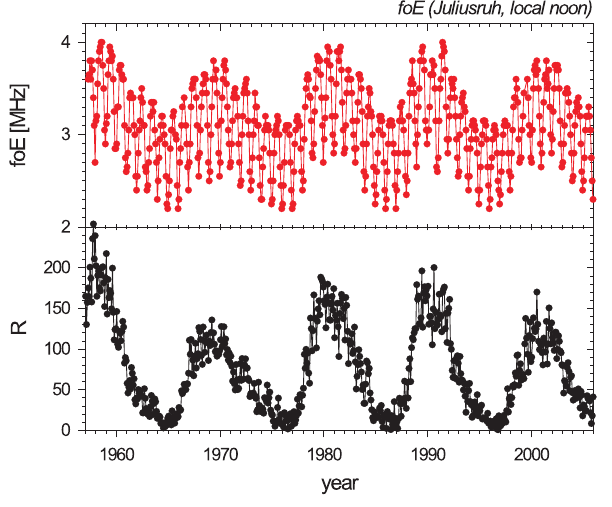
Fig. 1. Long-term variations of monthly mean foE values of the ionosonde station Juliusruh at local noon (upper part) and of solar sunspot number R (lower part).